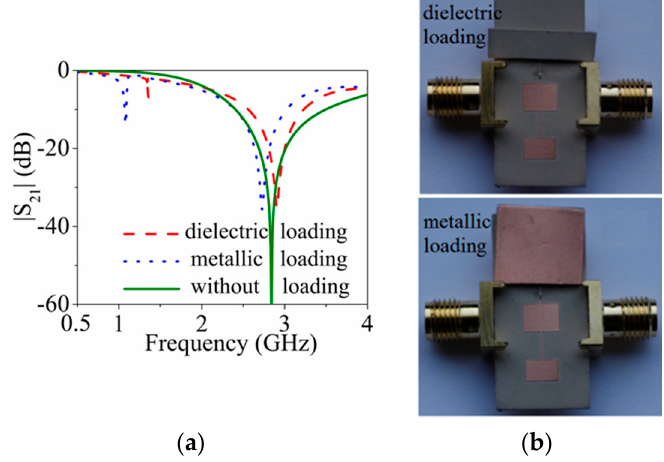
Figure 12. ( a ) Measured responses of the structure of Figure 7a with asymmetric dielectric loading and metallic loading; ( b ) fabricated prototypes loaded with dielectric loading and metallic loading, respectively. Reprinted with permission from [11].